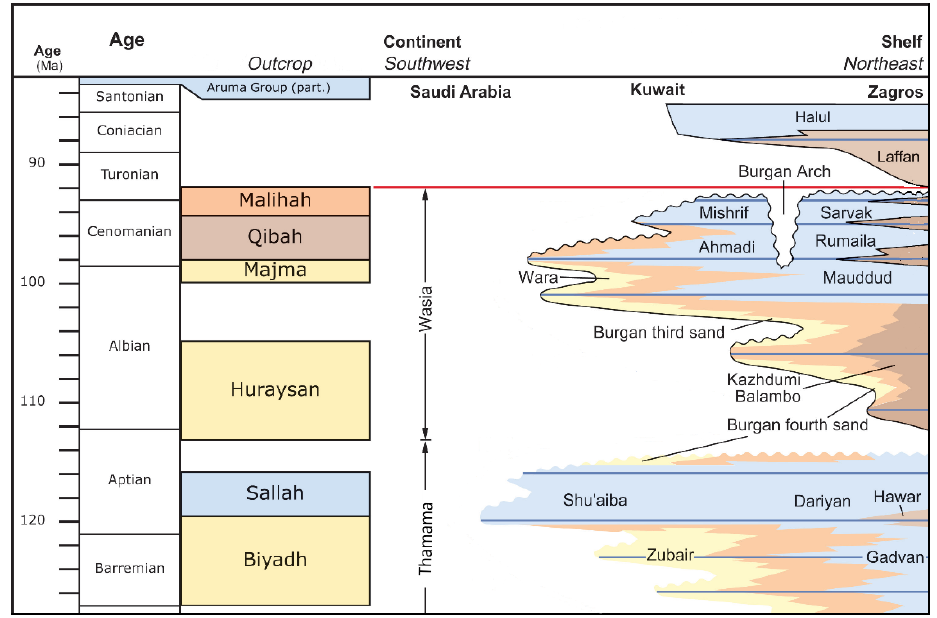
Figure 2. Stratigraphic chart of the Wasia Group and adjacent formations from the southwest to northeast of the Arabian Plate (modified from Reference [25]).